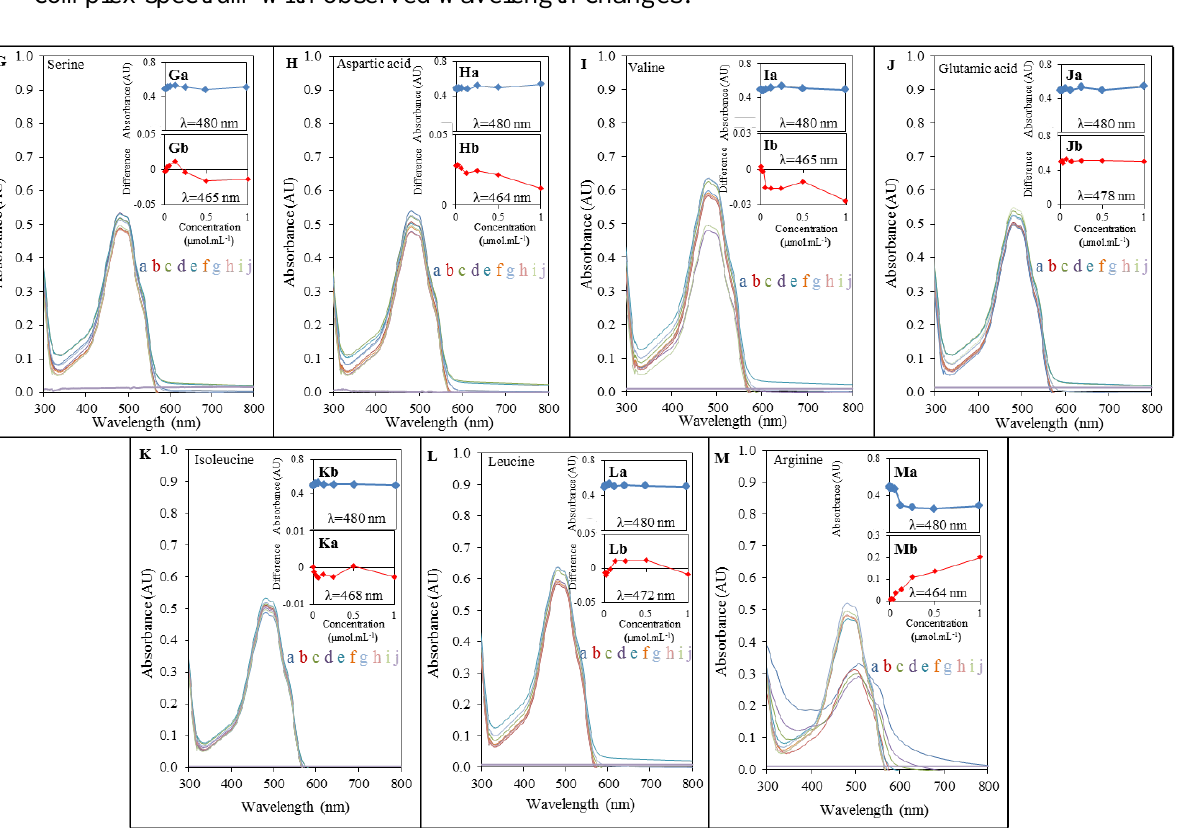
Figure 3. Interactions of amino acids (1; 2; 3; 6; 12; 25; 50; 100 µmol mL −1 ) with doxorubicin (100 µg mL −1 ) monitored with spectrophotometry. DOX interaction with: ( G ) serine; ( H ) aspartic acid; ( I ) valine; ( J ) glutamic acid; ( K ) isoleucine; ( L ) leucine; ( M ) arginine, where ( a ) stays for 100 µmol mL −1 ; ( b ) for 50 µmol mL −1 ; ( c ) 25 µmol mL −1 ; ( d ) 12 µmol mL −1 ; ( e ) 6 µmol mL −1 ; ( f ) 3 µmol mL −1 ; ( g ) 2 µmol mL −1 ; ( h ) 1 µmol mL −1 ; ( i ) 0 µmol mL −1 and ( j ) for control (AA without DOX). The dependence of the absorbance at 480 nm on the different concentrations of amino acids can be observed in insets marked with lowercase letter a. Insets marked with lowercase letter b express the differences obtained from differential spectra gained as readout of DOX spectrum from DOX-AA complex spectrum with observed wavelength